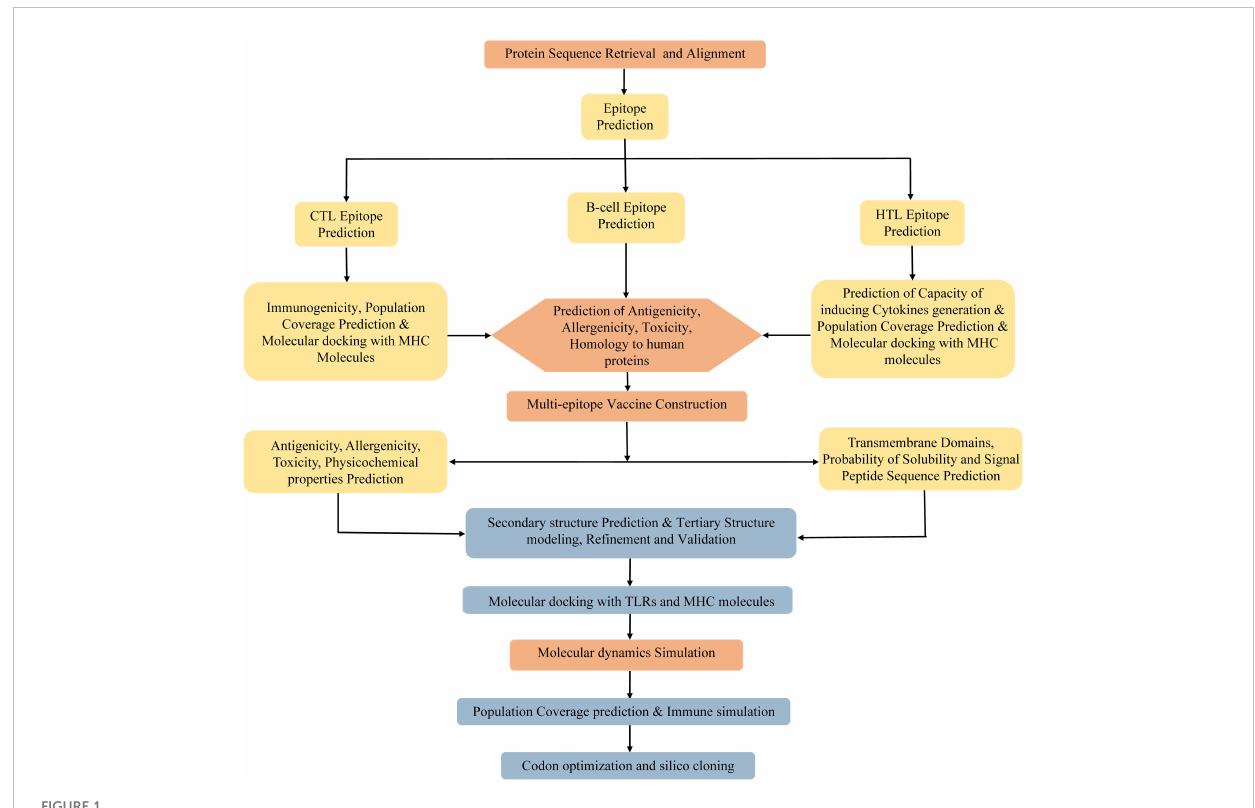
FIGURE 1 Flowchart of the multi-epitope vaccine